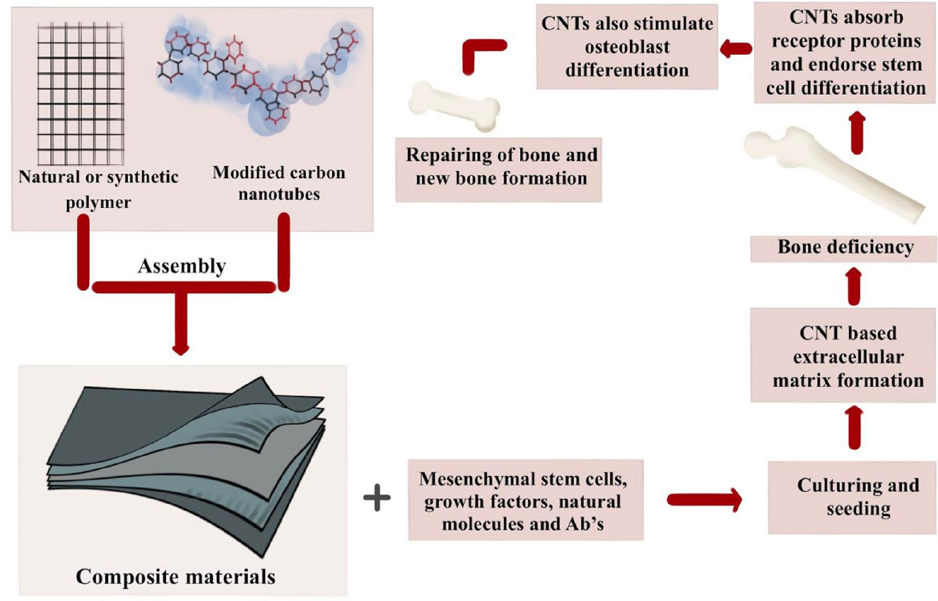
Figure 3. The fabrication process of carbon nanotubes and their roles in bone regeneration.